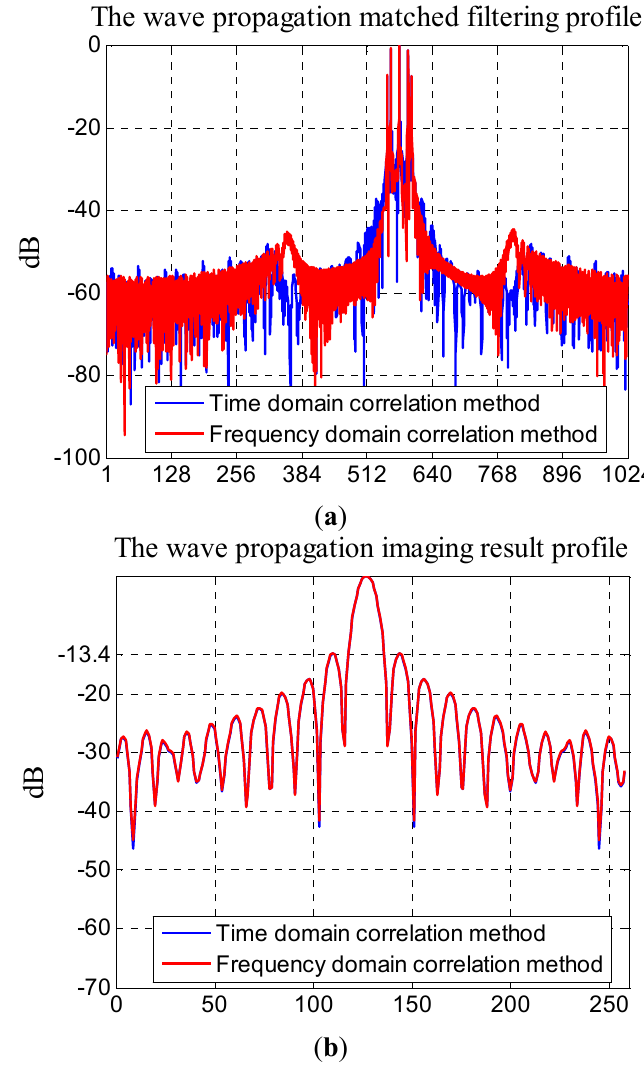
Figure 10. ( a ) The wave propagation matched filtering profile. ( b ) The wave propagation imaging result profile.